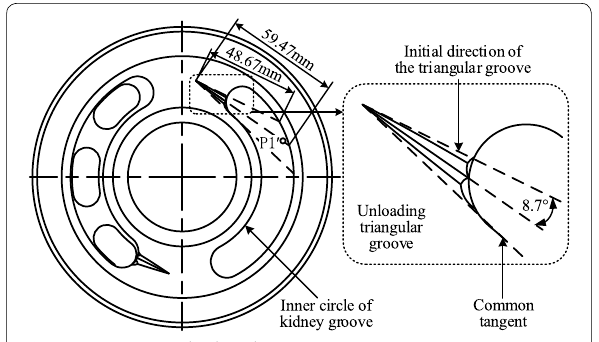
Figure 17 Improved valve plate structure